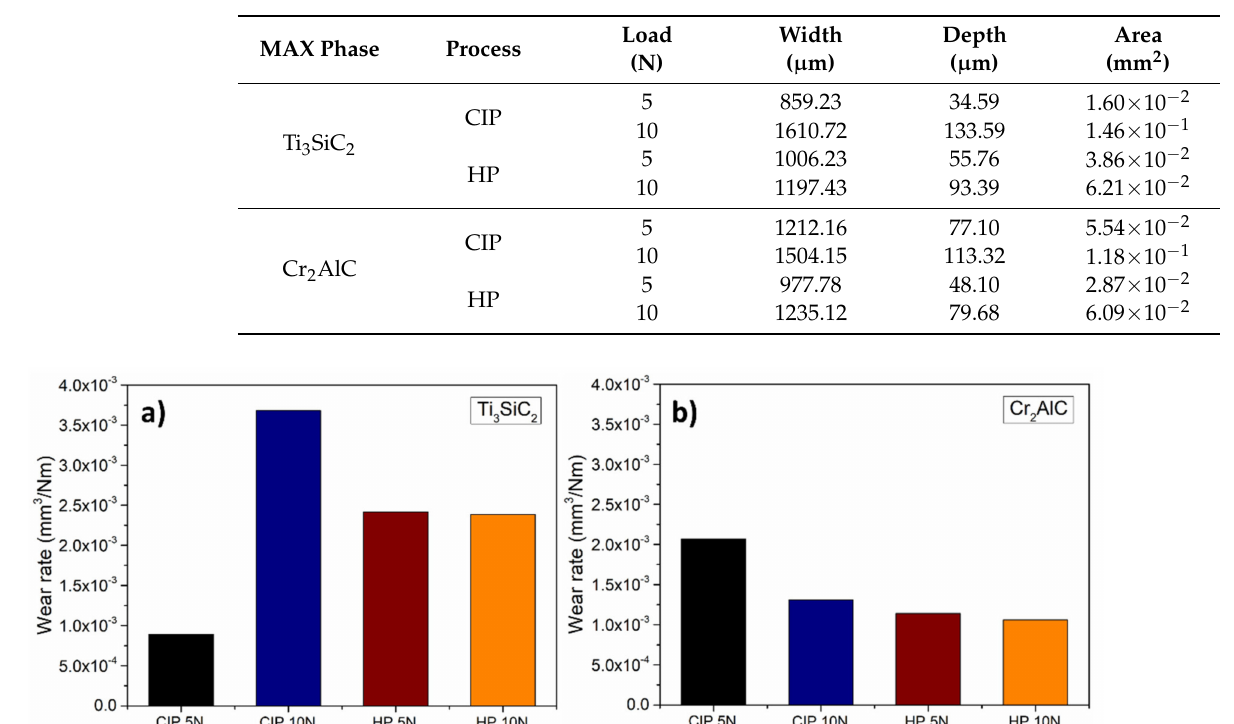
Table 5. The wear track mean values extracted from the 2D profiles and the wear rate calculations for the Ti 3 SiC 2 and Cr 2 AlC MAX phases processed by CIP and HP.